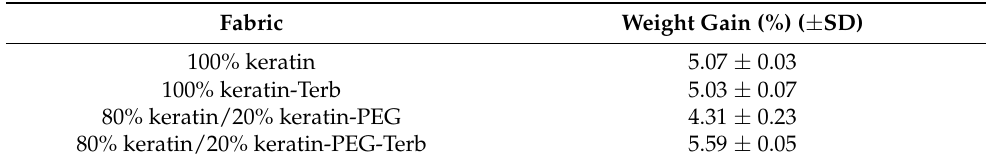
Table 2. Weight gain (%) of the cotton fabrics after functionalization with keratin-based particles (with and without